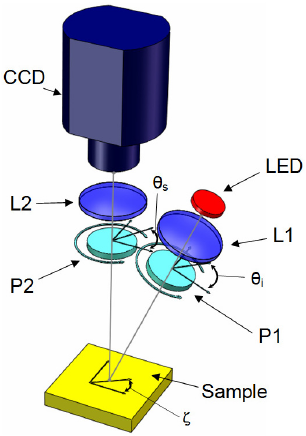
Fig. 1. Schematic of the RLPI system, P: polarizer, L: lens. Both P1 and P2 can be rotated around their optical axes to vary the polarization angles for both illumination ( (cid:1) i ) and detection ( (cid:1) s ).